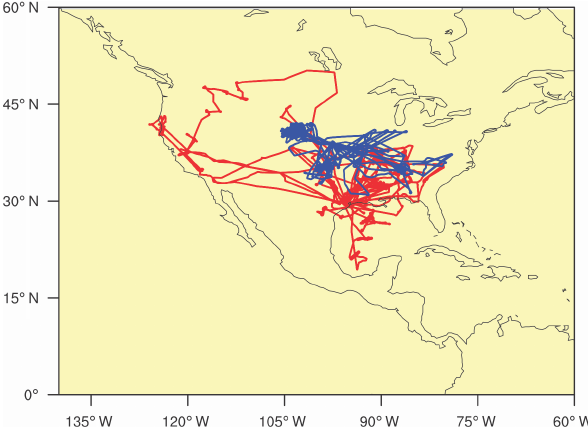
Figure 7. Flight tracks of the SEAC4RS (red) and DC3 (blue) field